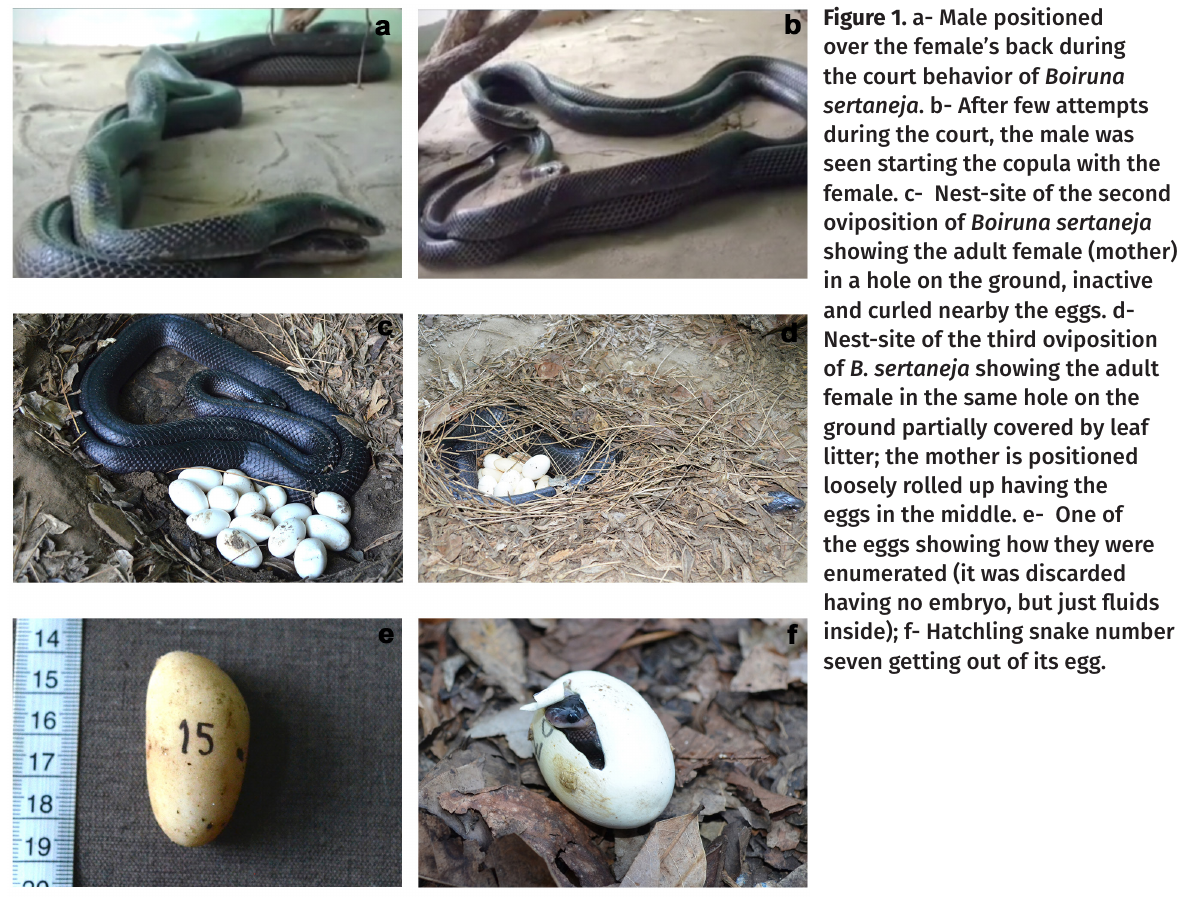
An Acad Bras Cienc (2020) 92(Suppl. 2) e20190588 4 | 11